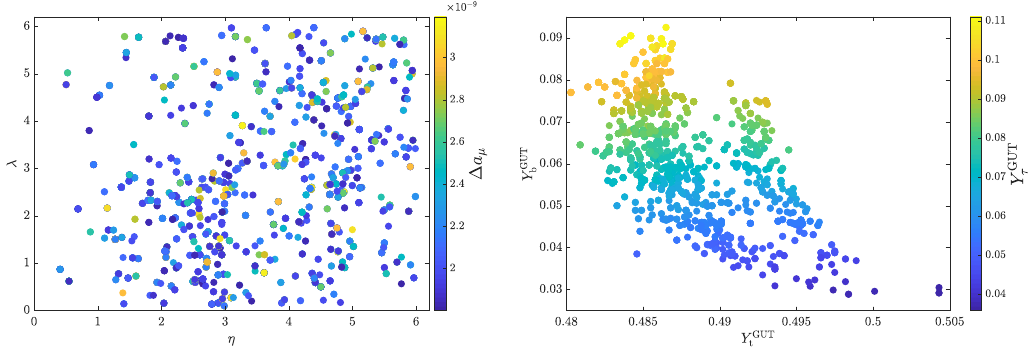
Figure 1 . Scatter plots resulting from the scan of input parameters from SO( 10 ) . The left panel shows the parameters η and λ with the color axis being the muon g − 2 . The right panel shows the top, bottom and tau Yukawa couplings at the GUT